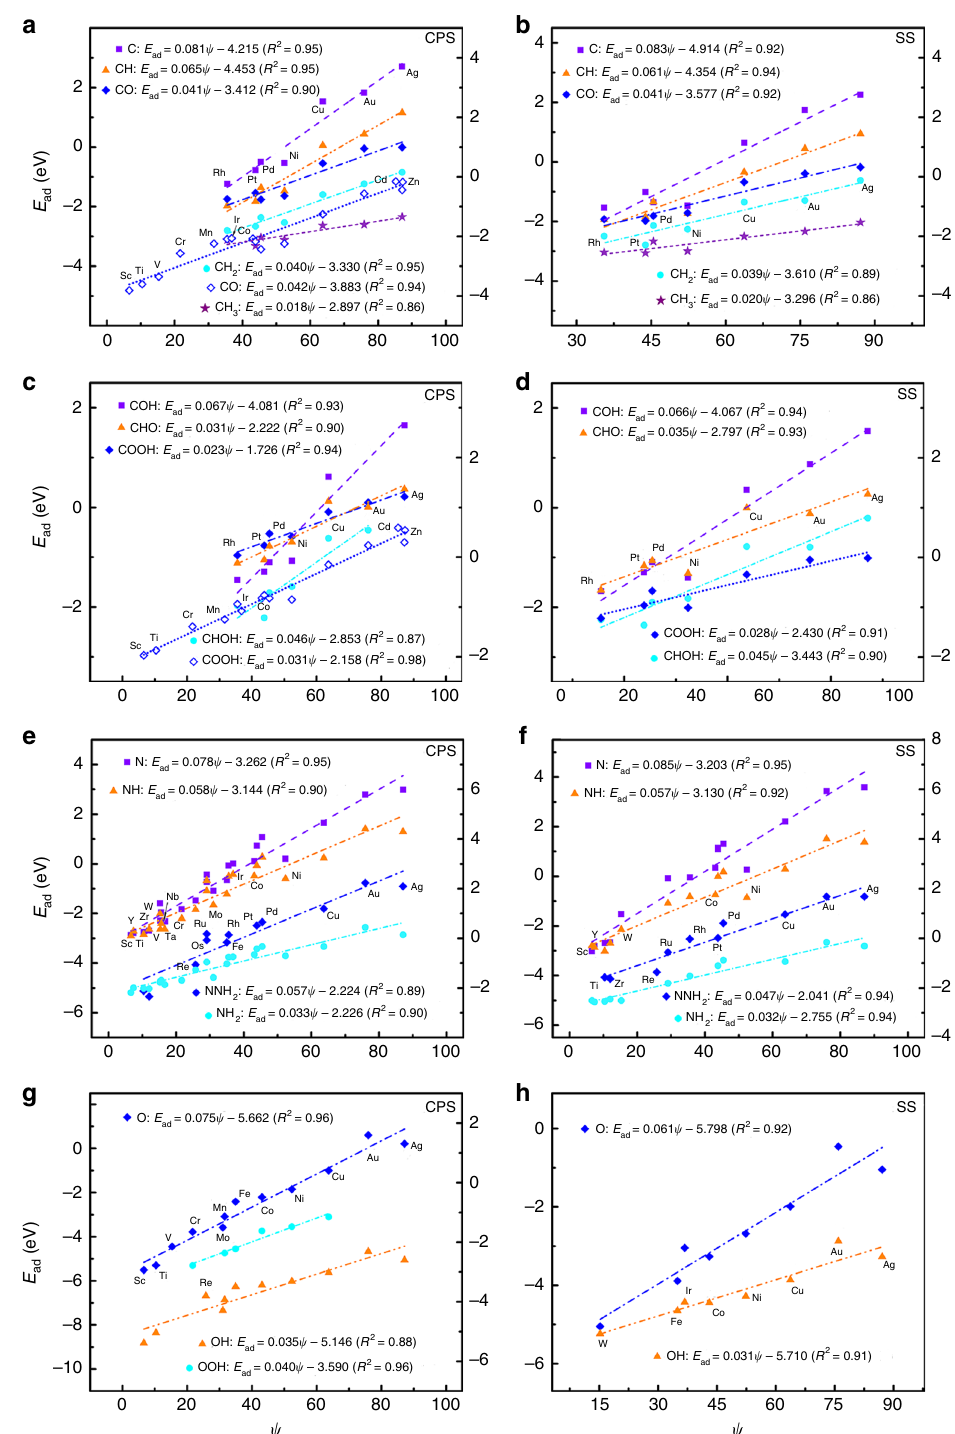
Fig. 1 Adsorption energies of small molecules on transition metals (TMs) as a function of the electronic descriptor ψ . a , b CH x and CO on close-packed ( a ) and stepped ( b ) surfaces (CPS and SS) of pure TMs 15 . c , d COH, CHO, COOH, and CHOH on CPS ( c ) and SS ( d ) of pure TMs 15 . e , f NH x and NNH 2 on CPS ( e ) and SS ( f ) of pure TMs 16 . g , h OH x and OOH on CPS 37,40 ( g ) and SS 11 ( h ) of pure TMs. In each panel, the adsorption energies of adsorbates are linearly correlated with the electronic descriptor ψ . The adsorbate name, the color code, and the linear fi ts are provided as insets and the corresponding parameters are summarized in Supplementary Table 4. In each sub fi gure with both left and right axes, the linear fi ts at the upper left corner correspond to the left coordinate axis and those at the bottom right corner correspond to the right coordinate axis. Clearly, the adsorption energy scales linearly with ψ , whereas the slope k is governed by electron-counting rules and can be described by the unsaturated bond number of the central atom in adsorbates. Source data are provided as a Source Data fi